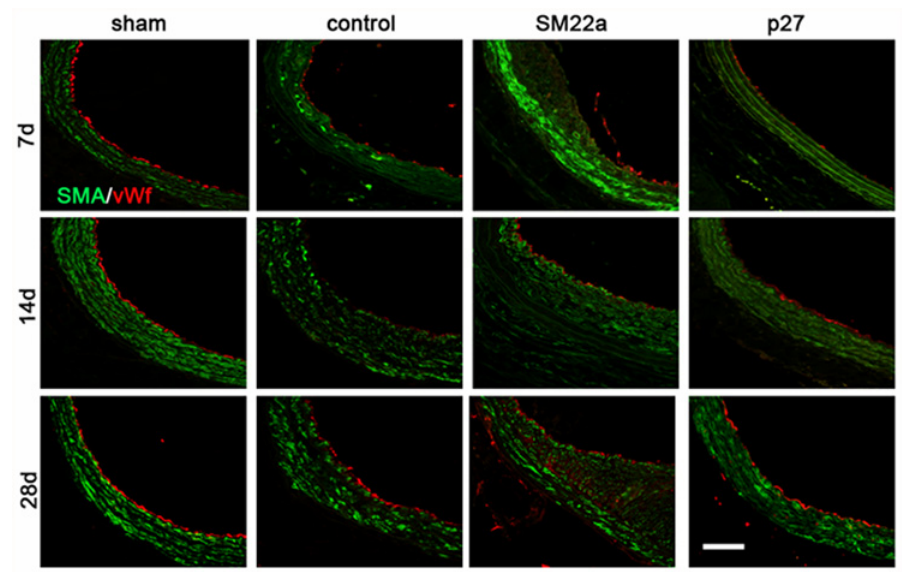
Fig 6. Re-endothelialization with Lenti-SM22alpha-p27 in Rat Carotid Artery Balloon Injury models. vWF immunofluorescence staining in sham, control, SM22a and p27 carotid artery groups at 7, 14, and 28 days after the balloon injury. vWF is shown in red, SMA is shown in green. Scale bar: 300 μ